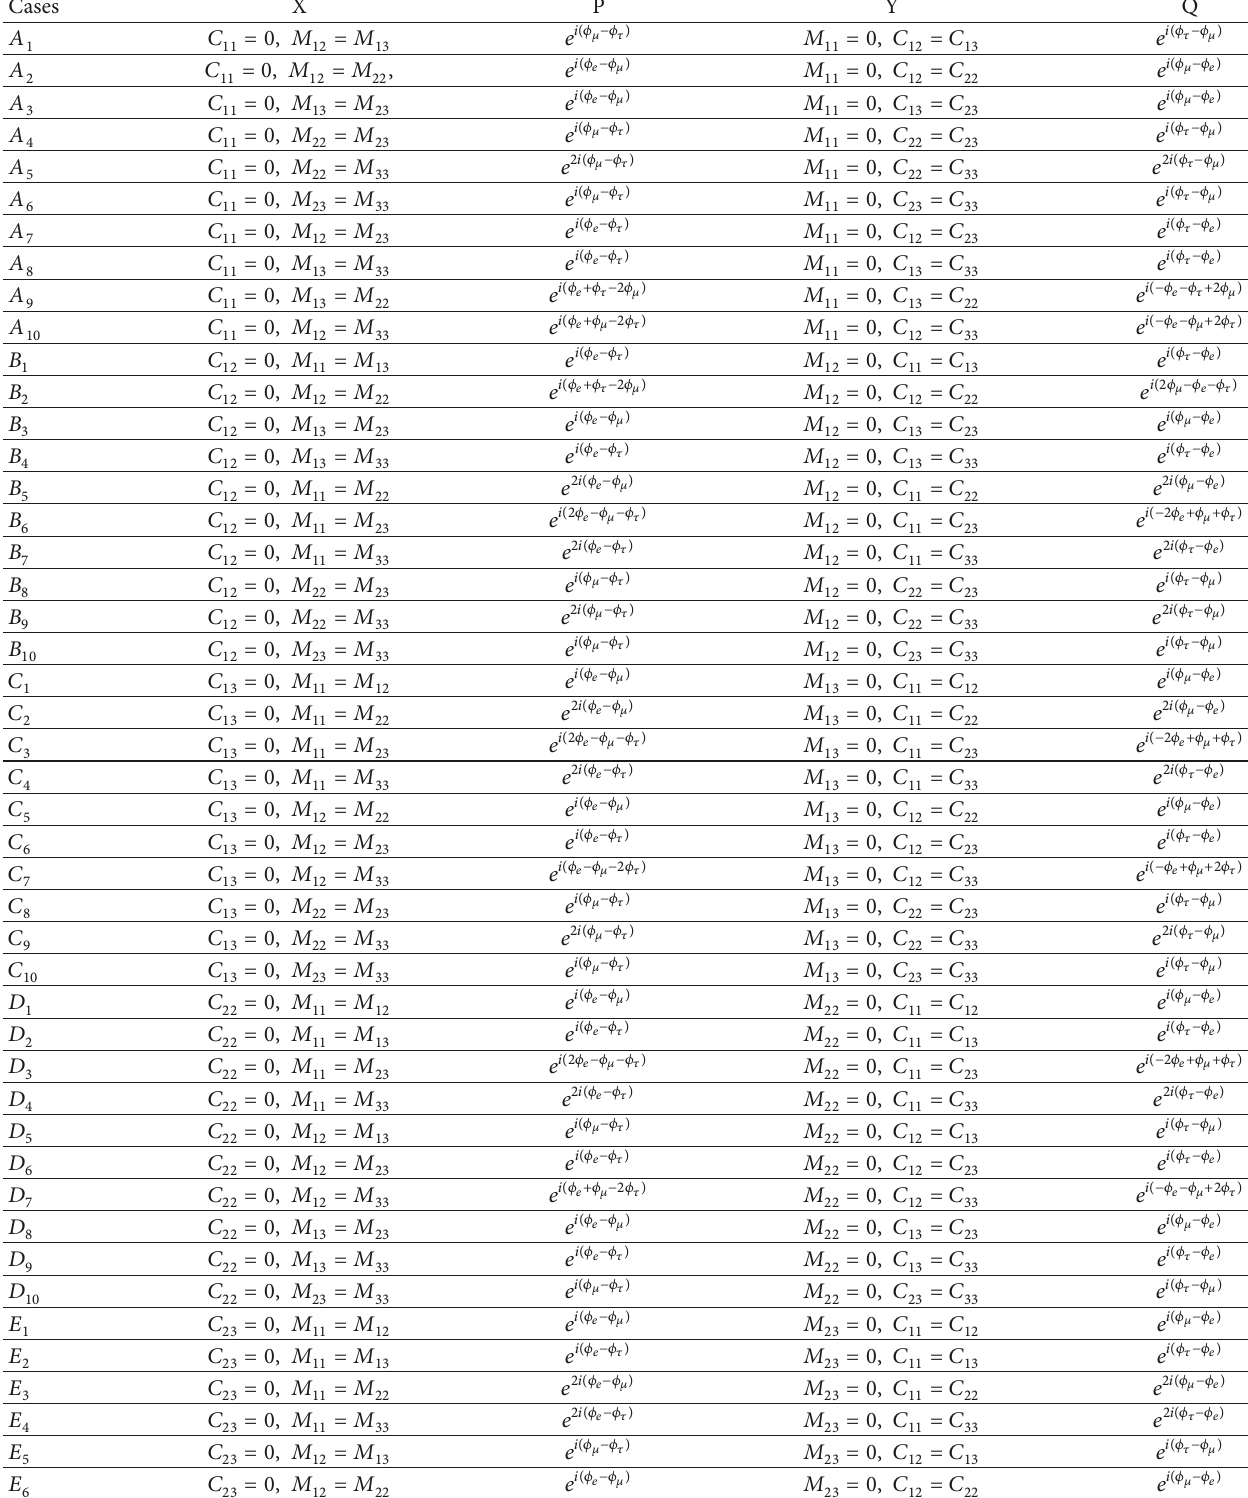
Table 2: All the sixty phenomenological possible cases belonging to types X and Y, respectively, have been shown. P and Q are unobservable phases associated with types X and Y,